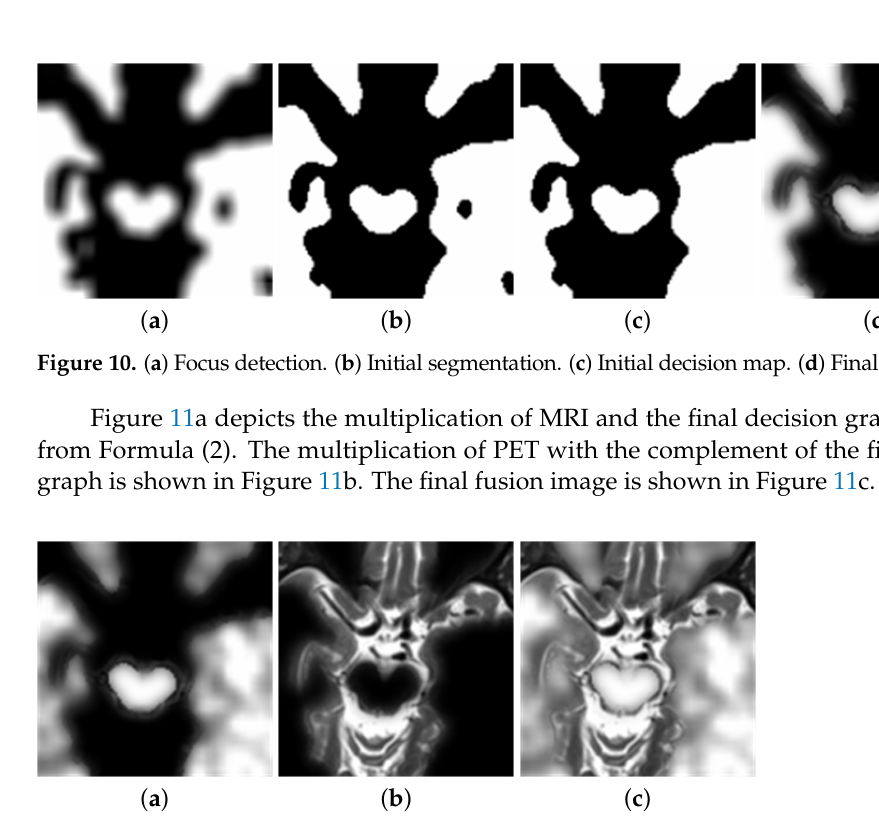
Figure 11. Image fusion. ( a ) The product of MRI and final decision map. ( b ) The product of PET and complementary set of final decision map. ( c ) Final fusion image.